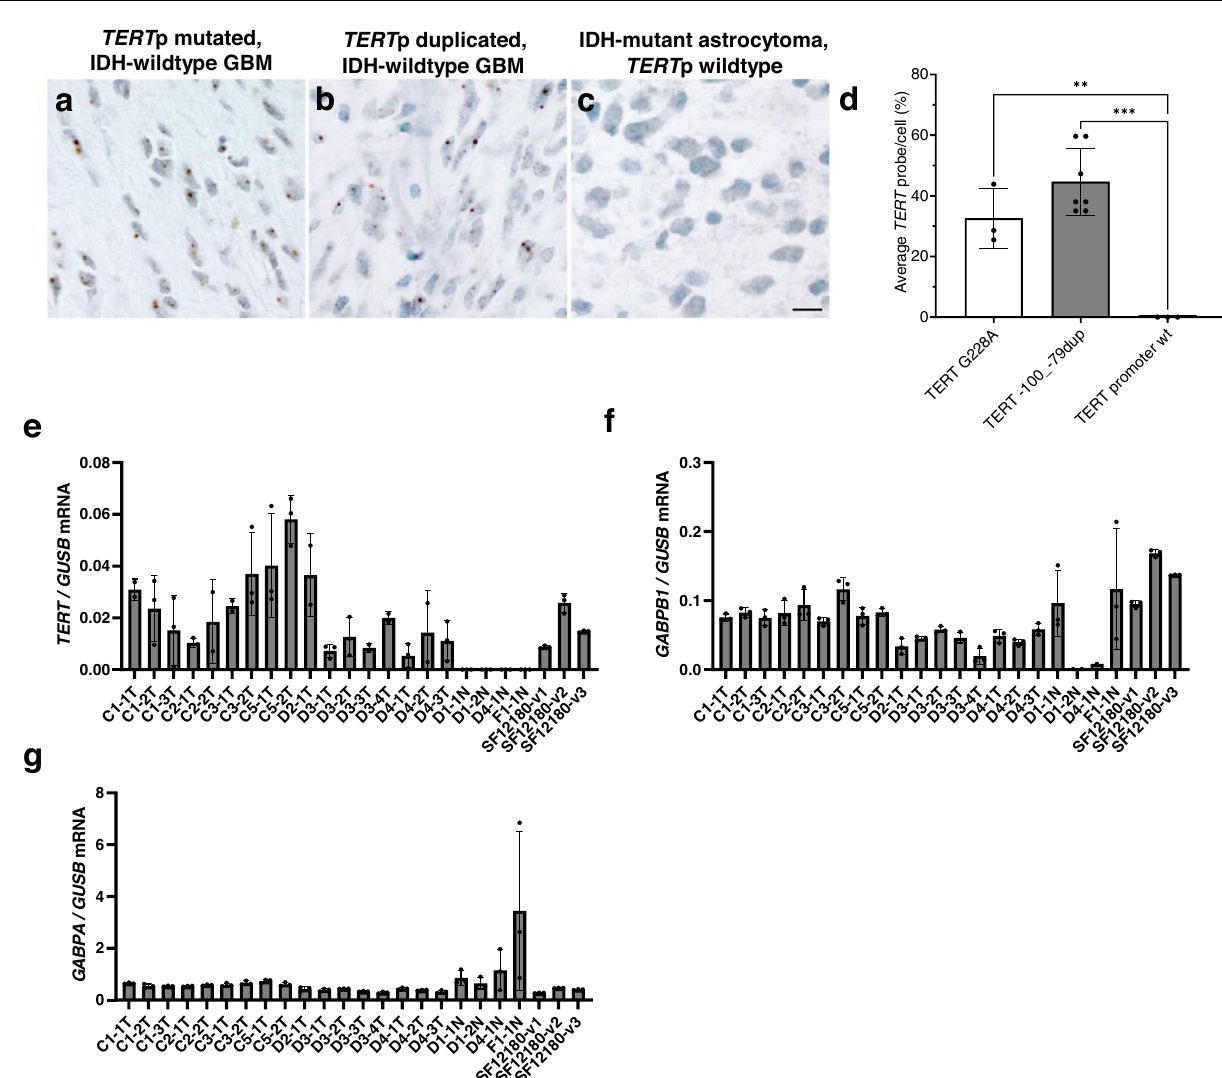
Fig. 5 | Similar TERT expression in glioblastomas with TERT promoter dupli- cation or hot-spot mutation. a – d RNAscope for TERT expression in human glioblastoma. Representative images from RNAscope demonstrating (a) TERT mRNA detected at the single cell level in a positive control glioblastoma, IDH- wildtypewith TERT G228A mutation, b TERT mRNA inglioblastoma, IDH -wildtype with TERT − 100_ − 79 duplicated (SF12747), (c) TERT mRNA in a negative control IDH-mutant astrocytoma with ATRX mutation and wildtype TERT p. Nuclei stained with hematoxylin. Scale bar denotes 30 µ m ( a – c ). d Quanti fi cation of the average TERT probepertotalcellnumber(%) forthe 3tumorsillustrated in( a – c ). N =1496 cells examined over 3 independent experiments for TERT G228A, n =3204 cells